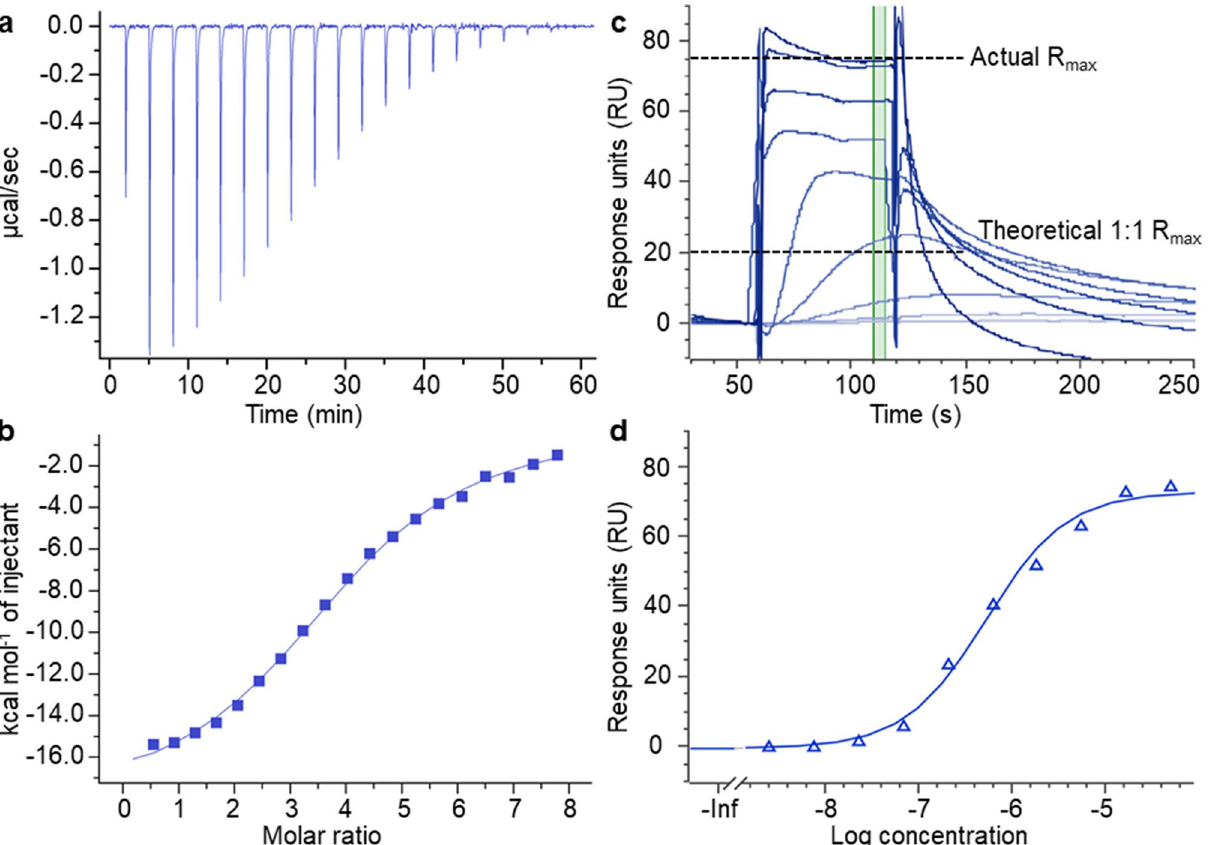
Figure 2. Neomycin binding to pre-miR-21. ( b ) ITC data showing heat evolution upon titrating neomycin to oligoribonucleotide 2 (10 µM). ( b ) Integrated peak areas from panel ( a ) versus neomycin: 2 molar ratio for the successive additions and the fitted curve (solid line, assuming a 1:1 binding) yielding a K d of 5.2 ± 0.8 µM. ( c ) Neomycin binding to oligoribonucleotide 3 at 10 different concentrations using SPR, where the green marked region shows steady-state conditions from which K d values are determined. ( d ) The fitted curve (solid line, assuming an equivalent affinity for all binding sites) from panel ( c ) yielding an average K d of 3.9 ± 2.8